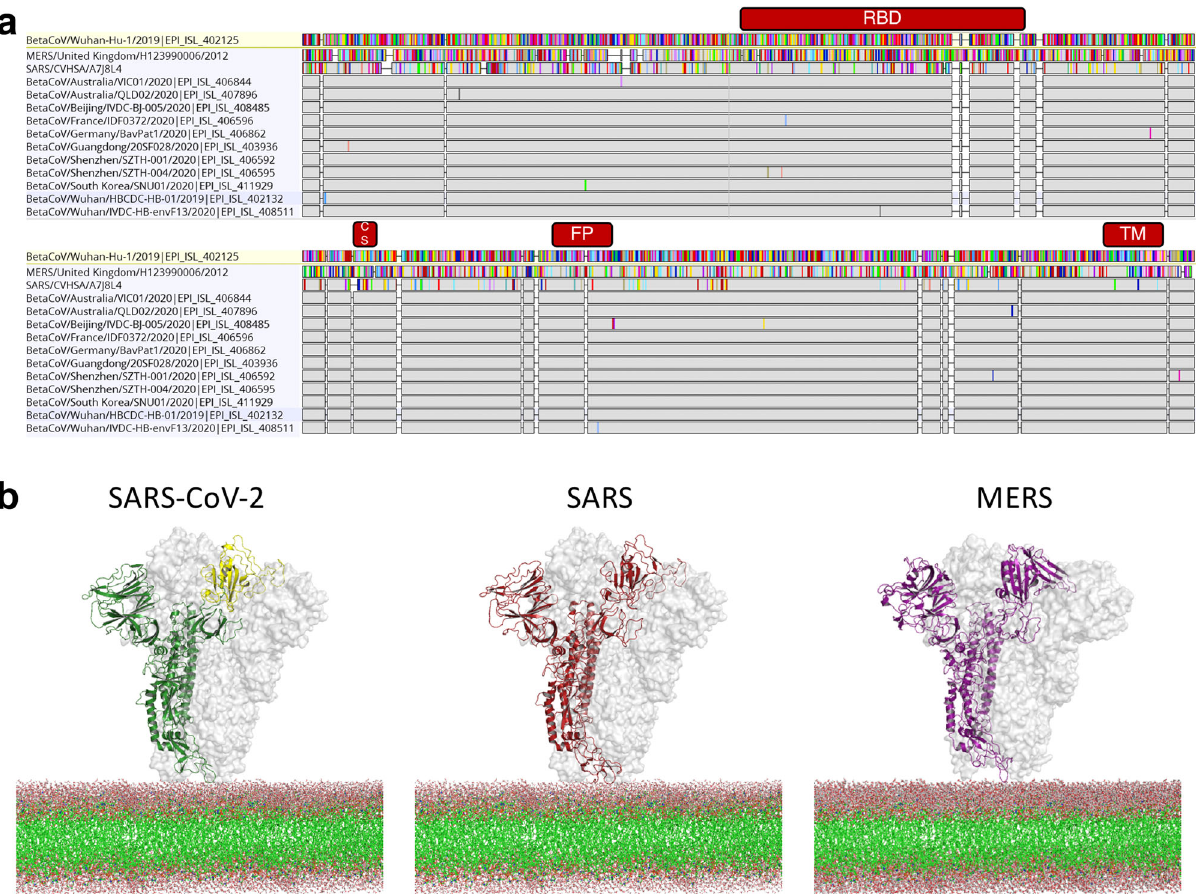
Fig. 1 Comparison of SARS-CoV-2, SARS-CoV and MERS-CoV spike glycoproteins. a Amino acid alignment of coronavirus spike proteins including 11 SARS-CoV-2 sequences with mutations (GISAID). Gray bars indicates identical amino acids and colored bars represent mutations relative to Wuhan-Hu-1. RBD, Cleavage Site, Fusion Peptide and Transmembrane domains are indicated in red. b Structural models for SARS-CoV-2, SARS and MERS spike glycoproteins with one chain represented as cartoon and two chains represented as surface. RBD of SARS-CoV-2 is colored